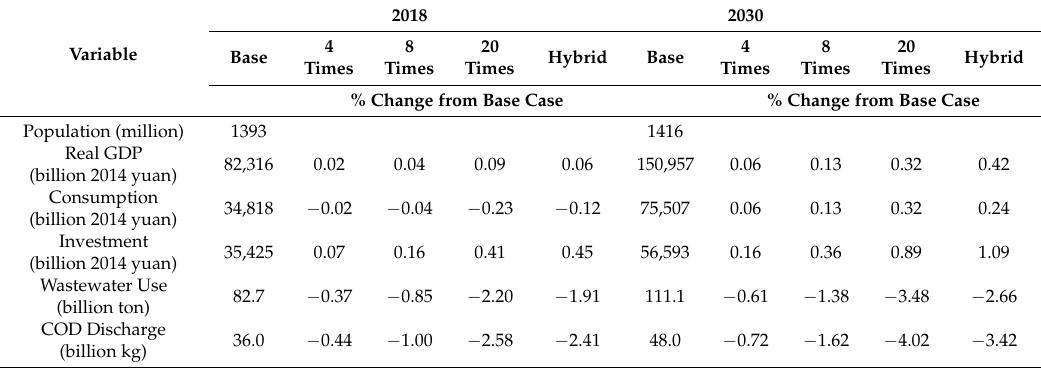
Table 2. The overall impacts of different water pollution tax scenarios compared with the baseline.